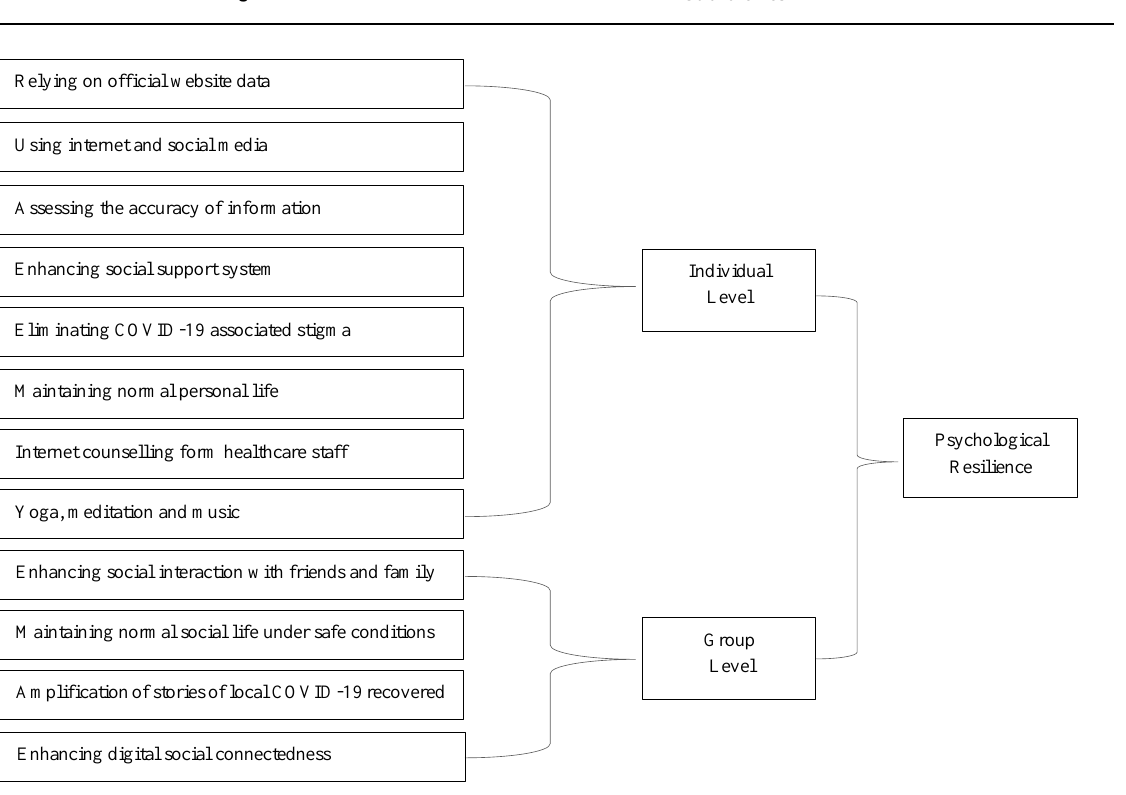
Figure 2: Categorization of data in sub-themes and themes (Resilience